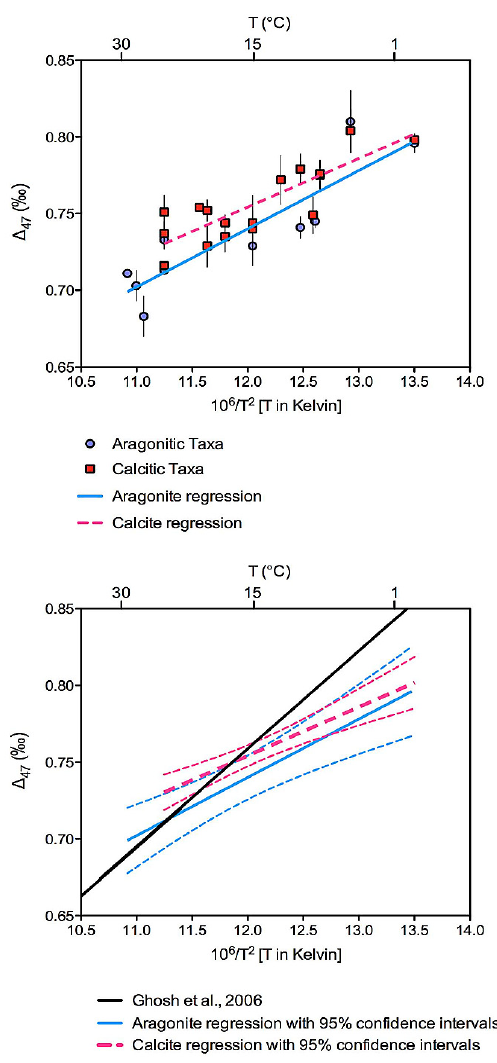
Fig. 4. Comparison of bivalve 1 47 data derived from calcitic and aragonitic taxa. The top panel shows data split between calcitic (squares) and aragonitic (circles) mollusks, with a linear regression through each. Here cultured and field collected samples are not dis- tinguished in the figure. The bottom panel shows linear regressions with 95% confidence intervals. There is an offset between the re- gressions between calcite and aragonite, but it is not statistically